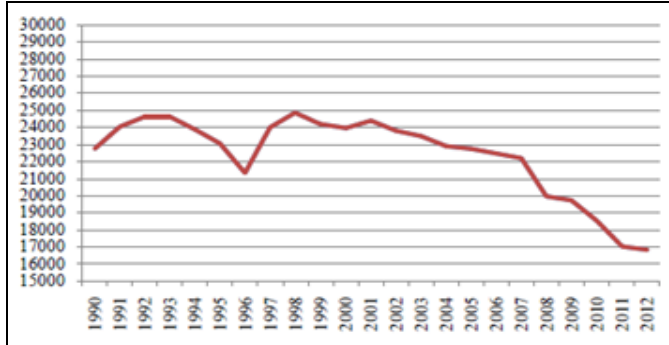
Figura 1: Evolución del censo de ovino en España, en miles de cabezas